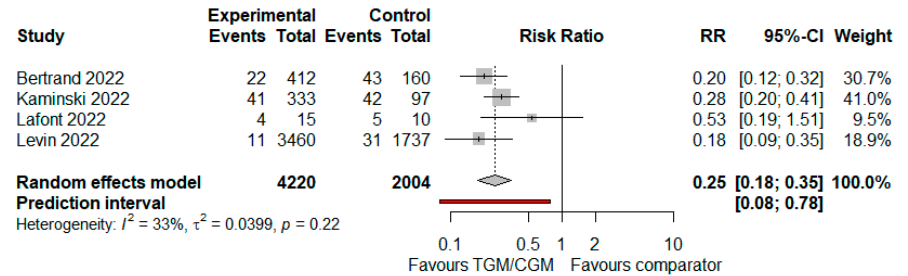
Figure 13. Proportion of patients who had symptomatic COVID-19 (TGM/CGM vs. comparator). CI, confidence interval; RR, risk ratio; TGM/CGM, tixagevimab/cilgavimab.